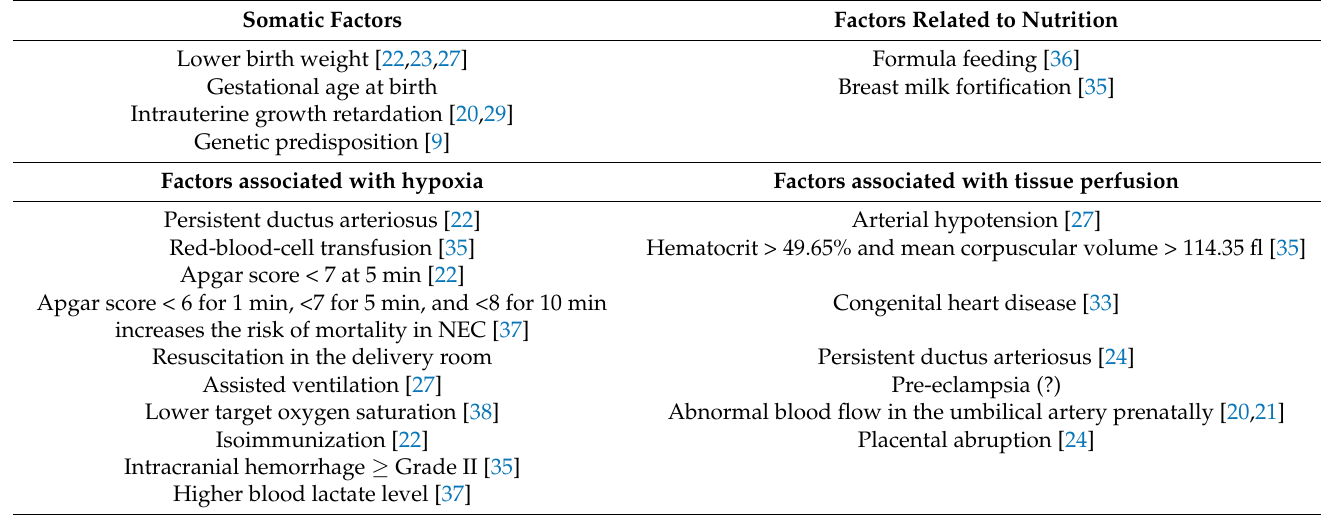
Table 1. Groups of risk factors of necrotizing